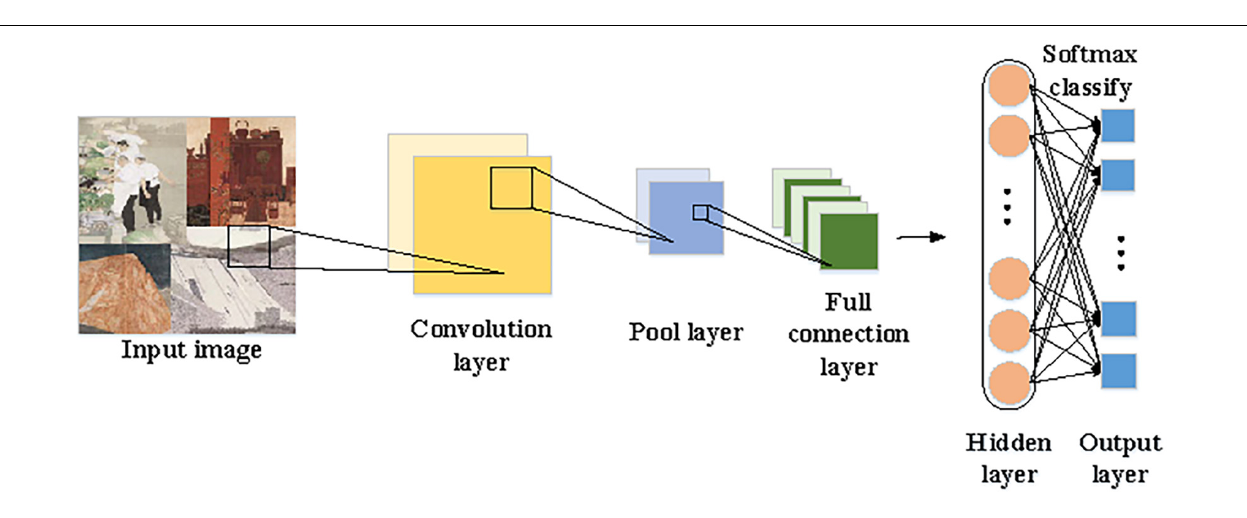
FIGURE 2 | Procedures of CNN processing and recognizing Chinese